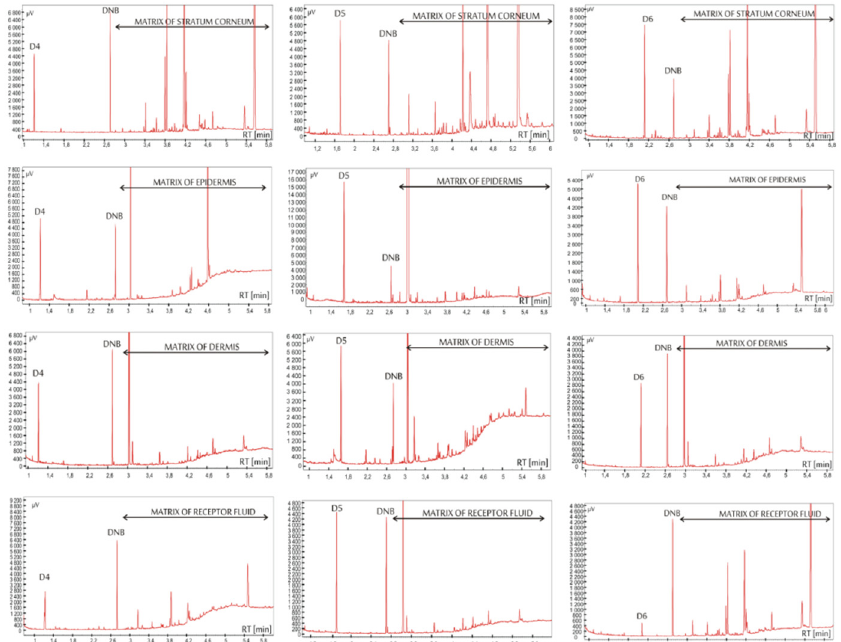
Figure 3. Representative chromatograms of the extracts obtained from the fractionated layers of the skin (stratum corneum, epidermis, and dermis) and from the receptor fluid containing octamethylcyclotetrasiloxane (D4), decamethylcyclopentasiloxane (D5), dodecamethylcyclohexasiloxane (D6), respectively; the internal standard (1,4-dinitrobenzene (DNB) was added at a concentration of 5 µg/mL.